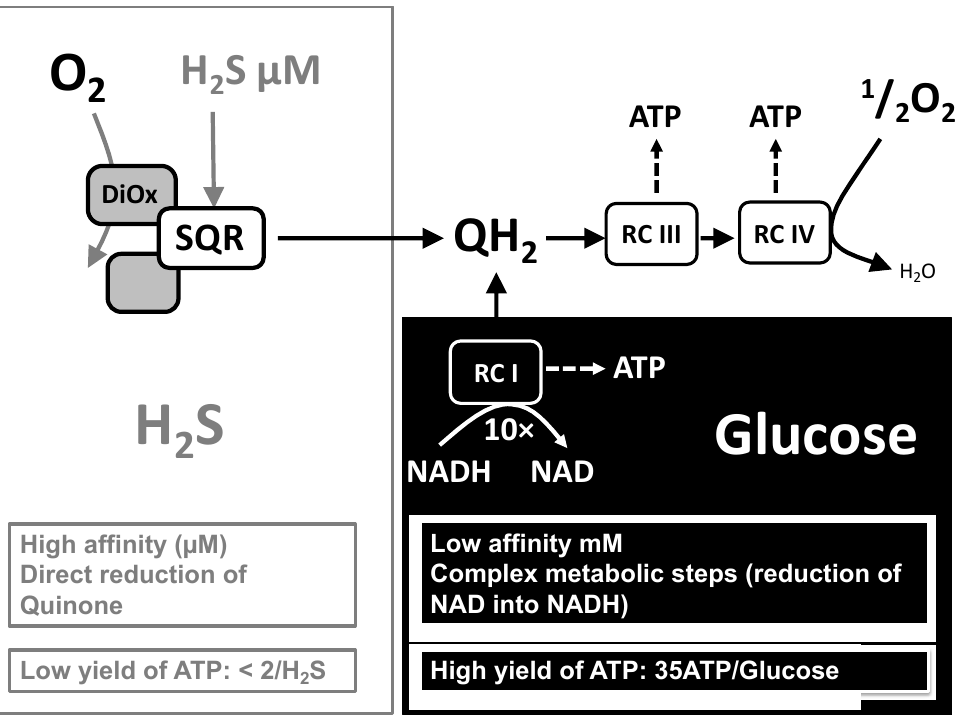
Figure 7. Comparison of the two energy substrates glucose and sulfide. Physiological concentrations of glucose in the external medium are maintained in the millimolar range to ensure support of cellular metabolism. In contrast, the Km for rat liver mitochondrial SQR is 2 µM and evidencing sulfide oxidation in the nanomolar range is feasible (Supplementary Figure S1). Glucose oxidation into carbon dioxide implies ten metabolic steps reducing NAD into NADH, the substrate for mitochondrial complex I. Other metabolic steps include substrate-linked ATP generation steps and reduction of quinone by complex II (not shown). Altogether, it results in a large difference between the yields expressed in ATP generated per substrate oxidized; a similar conclusion applies if oxygen consumption is considered (Figure 6 and text).